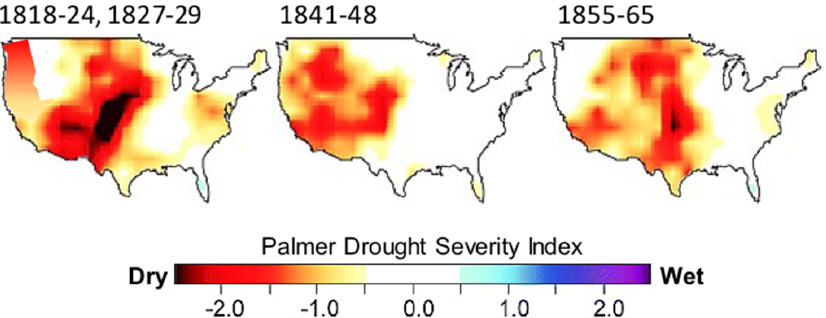
Figure 1. Mapped patterns of reconstructed PDSI for some intervals in 19th century across the U.S. (modified from Cole et al. [5]).